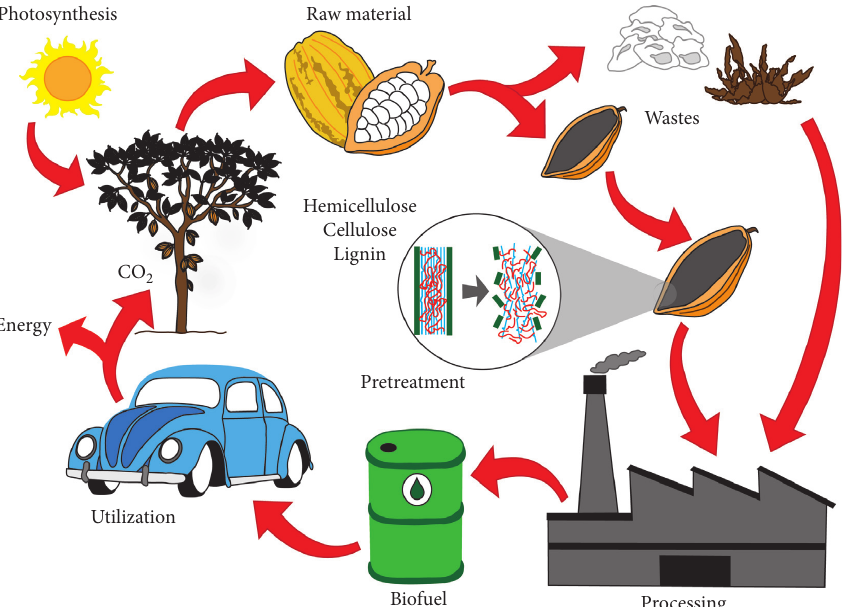
Figure 3: General cycle of obtaining biofuels from cocoa industrial